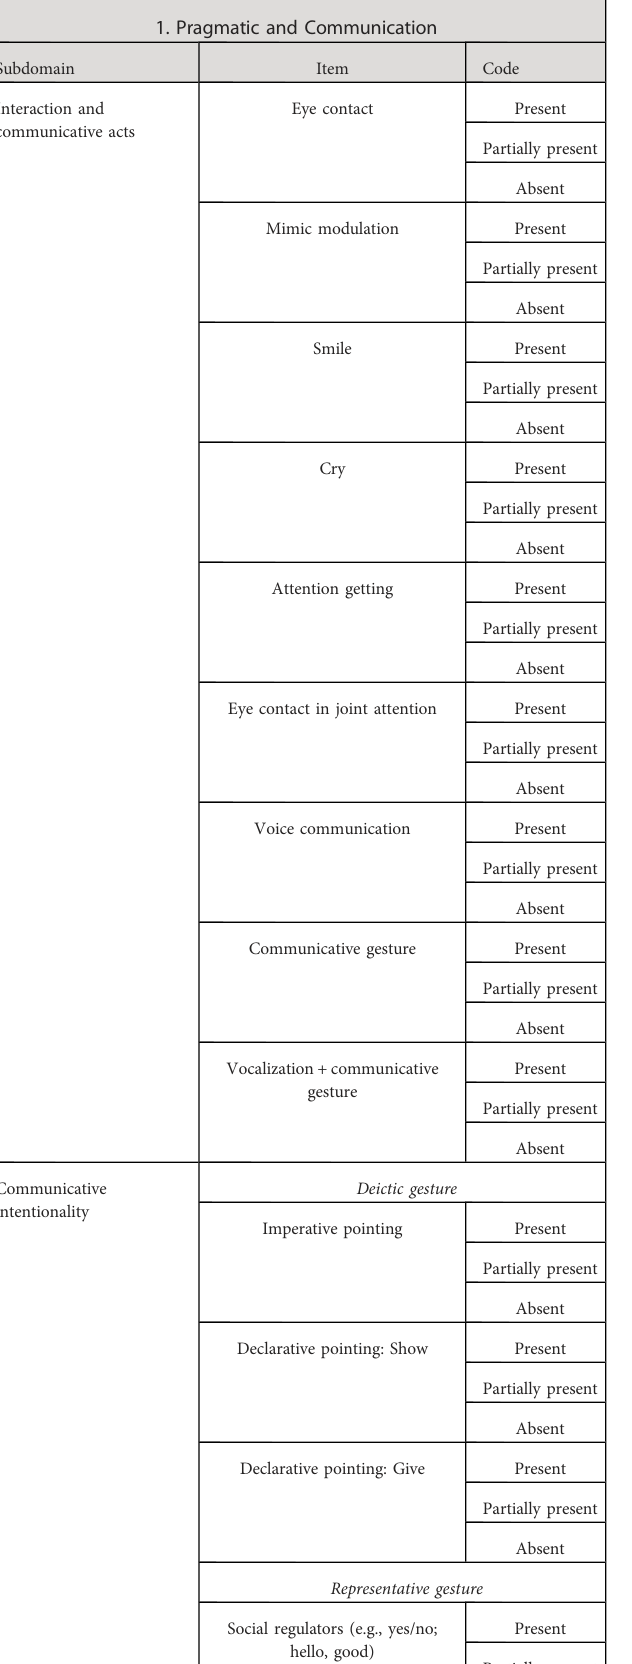
TABLE 1 Observation of the Prelinguistic Intersubjective and Socio- Communicative Skills (OPISCoS) form. 1. Pragmatic and Communication